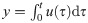
Simulation of DSD realized primitive components.(A) Concentrations of y
+, y
−, and y = y
+−y
− of the integration component computing y=∫0tu(τ)dτ under constant inputs u
+ = 2 and u
− = 1 nM. (B) Concentrations of y
+, y
−, and y = y
+−y
− of the weighted summation component computing y = 2u
1 + u
2 under constant inputs (u1+,u1−)=(5,3) and (u2+,u2−)=(2,1) in nM.